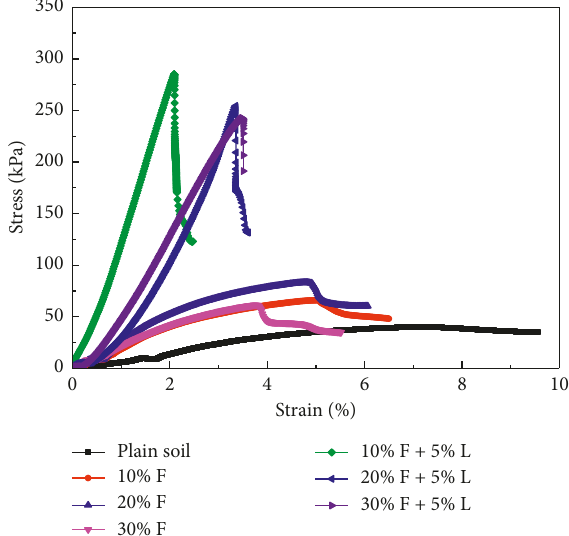
Figure 16: Stress-strain curves of the Brazilian splitting test.